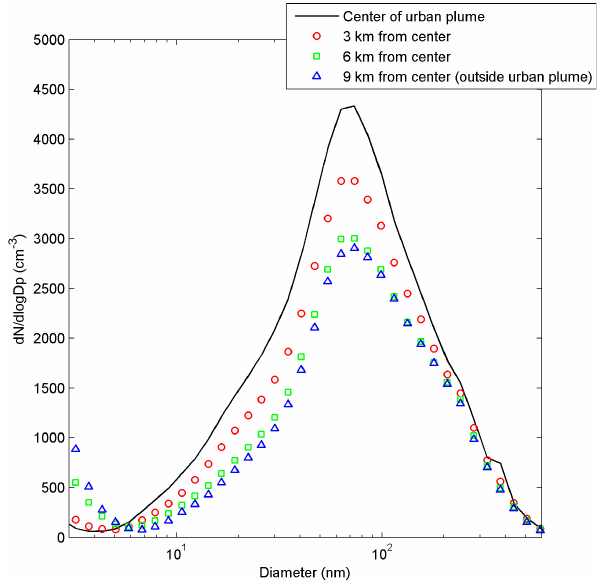
Fig. 4. Modeled average particle number size distributions at dif- ferent distances (perpendicular to the air mass trajectories) from the center of the urban plume at